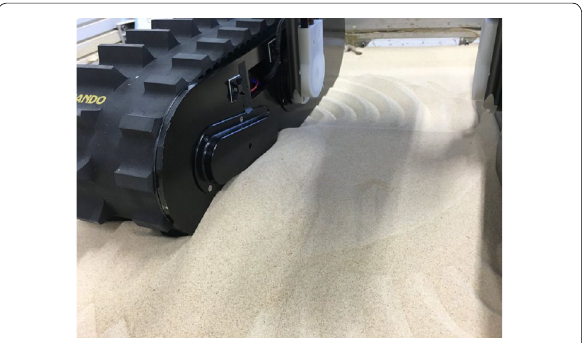
Fig. 19 Accumulated soil on the inner side of left